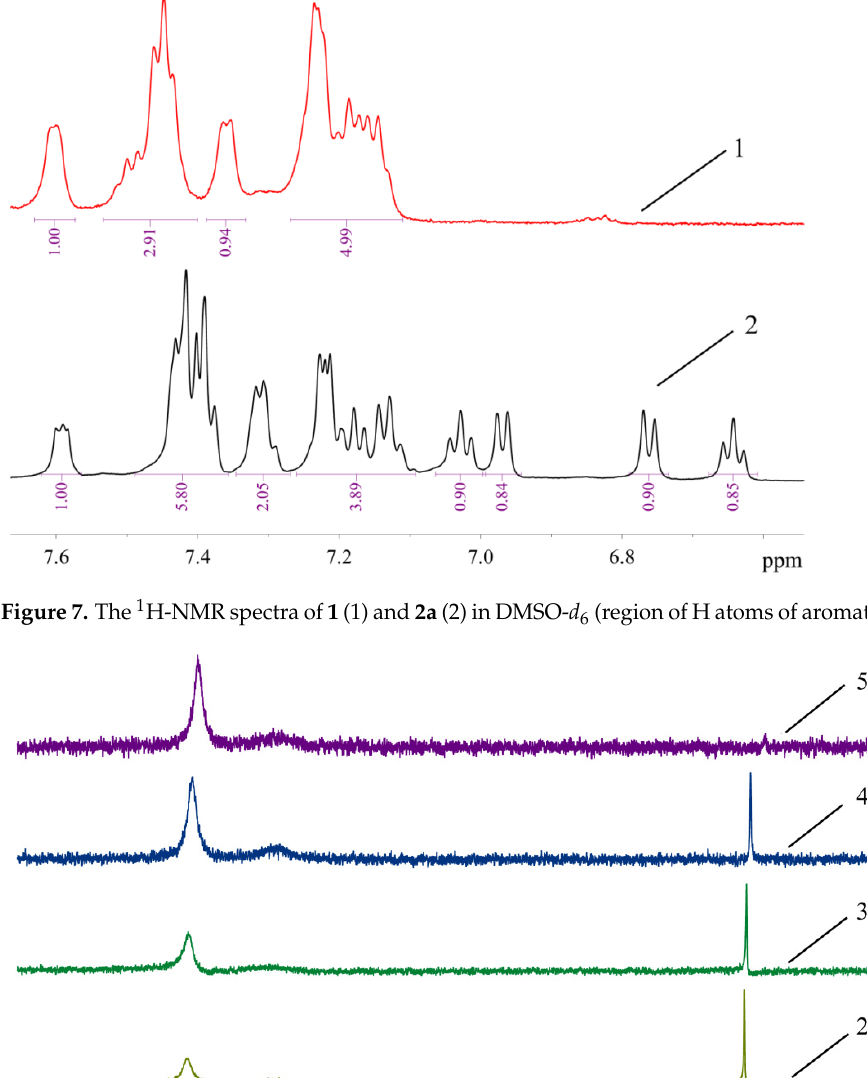
Figure 8. The 31 P-NMR spectra of XPhos Pd G3 in acetone (1), acetone:ethyl acetate = 2:1 (2), ace- tone:ethyl acetate = 1:1 (3), acetone:ethyl acetate = 1:2 (4) and ethyl acetate (5). acetone:ethyl acetate = 1:1 (3), acetone:ethyl acetate = 1:2 (4) and ethyl acetate